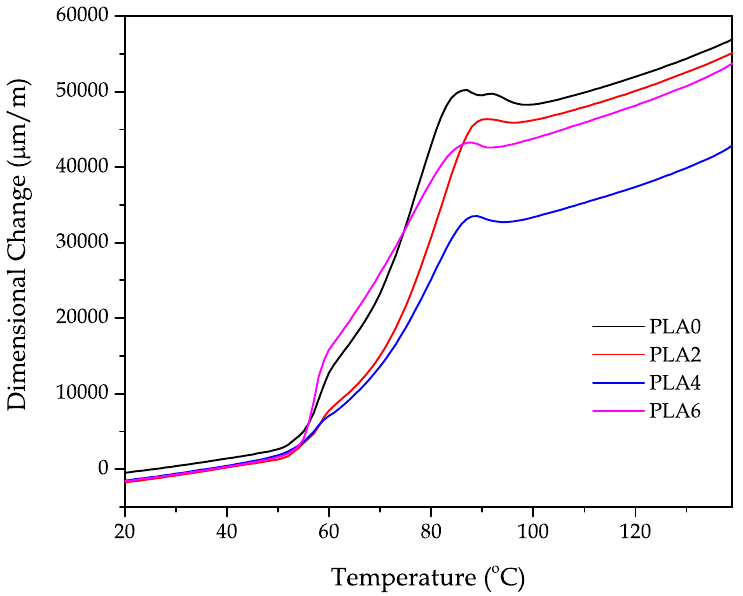
Figure 7. A comparative plot of the dimensional change of the injection-molded polylactide (PLA) pieces subjected to different reprocessing cycles.